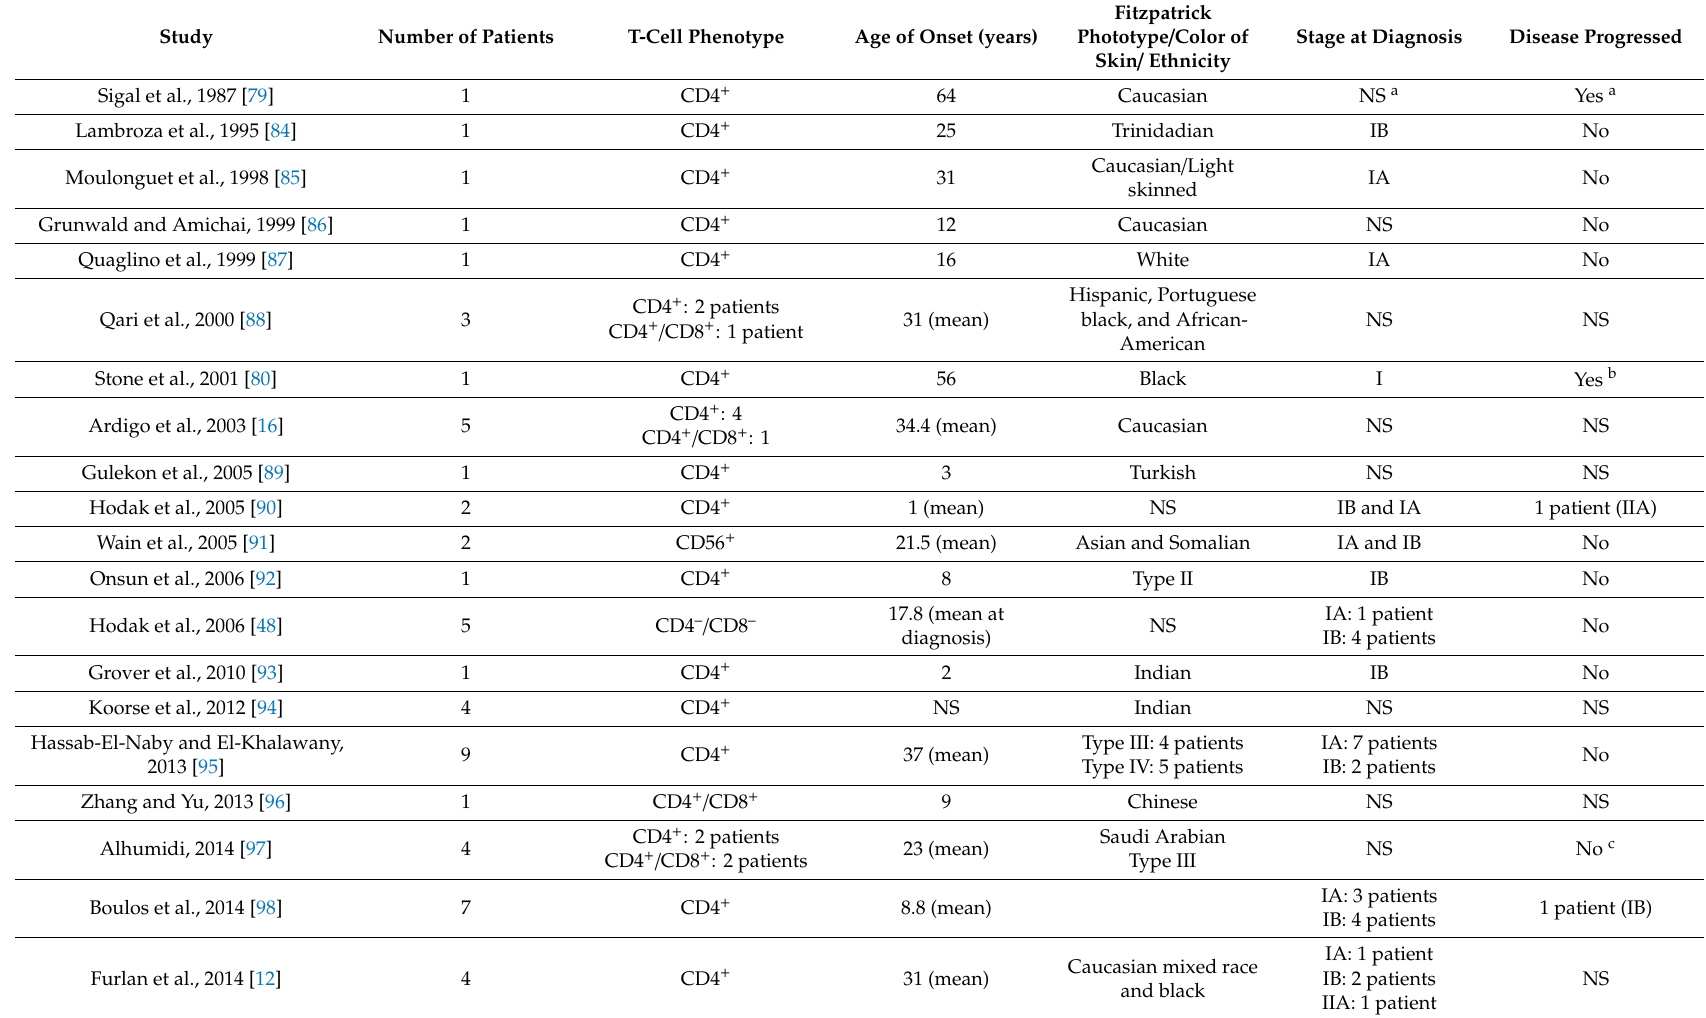
Table 1. Cases of hypopigmented mycosis fungoides with T-cell phenotype other than CD8 + . Cases published up to March